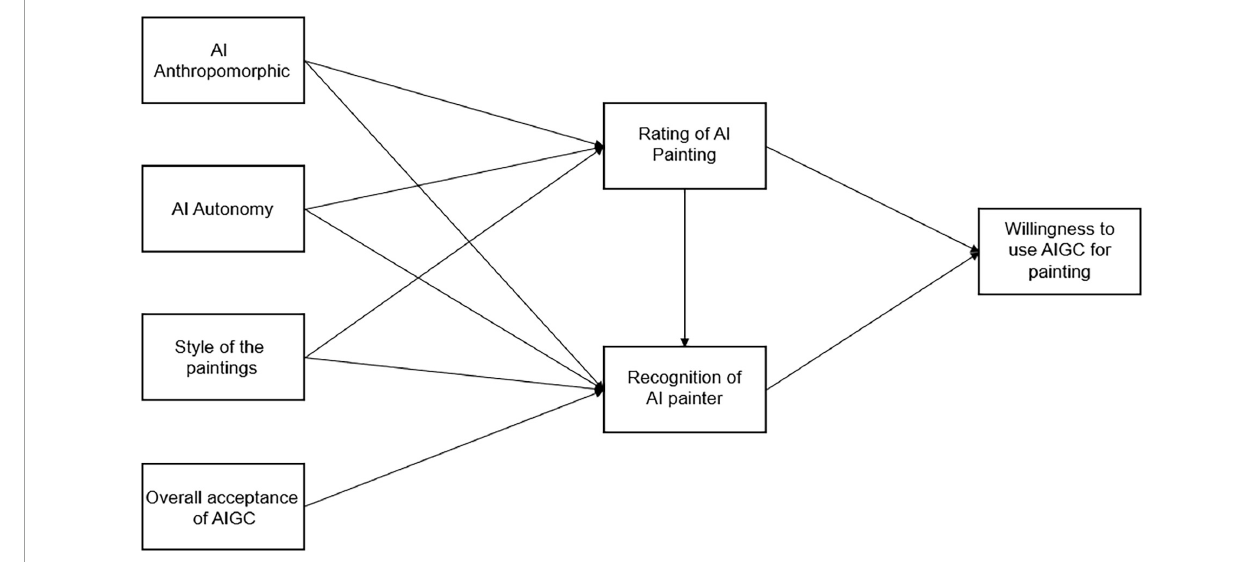
FIGURE1 Variable analysis path model.